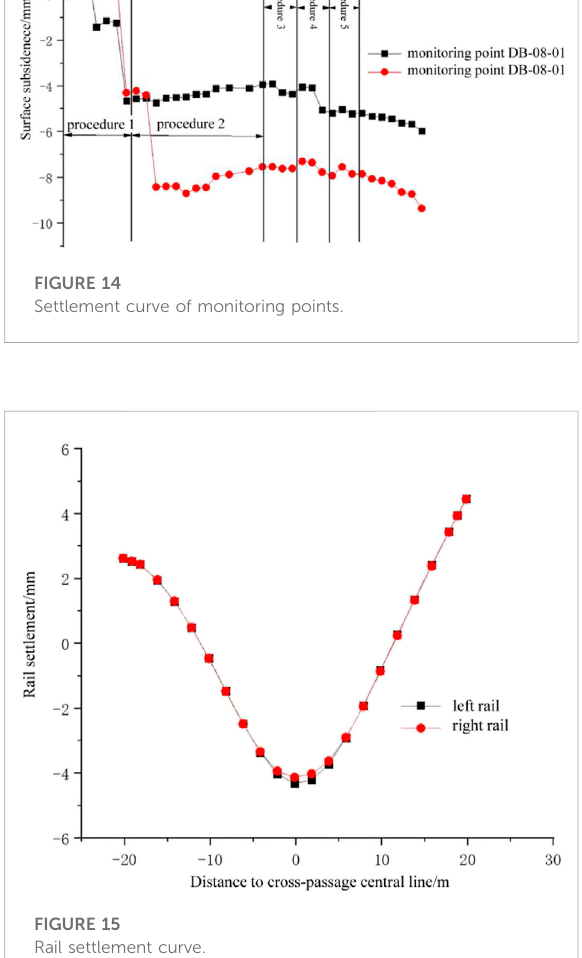
FIGURE 15 Rail settlement